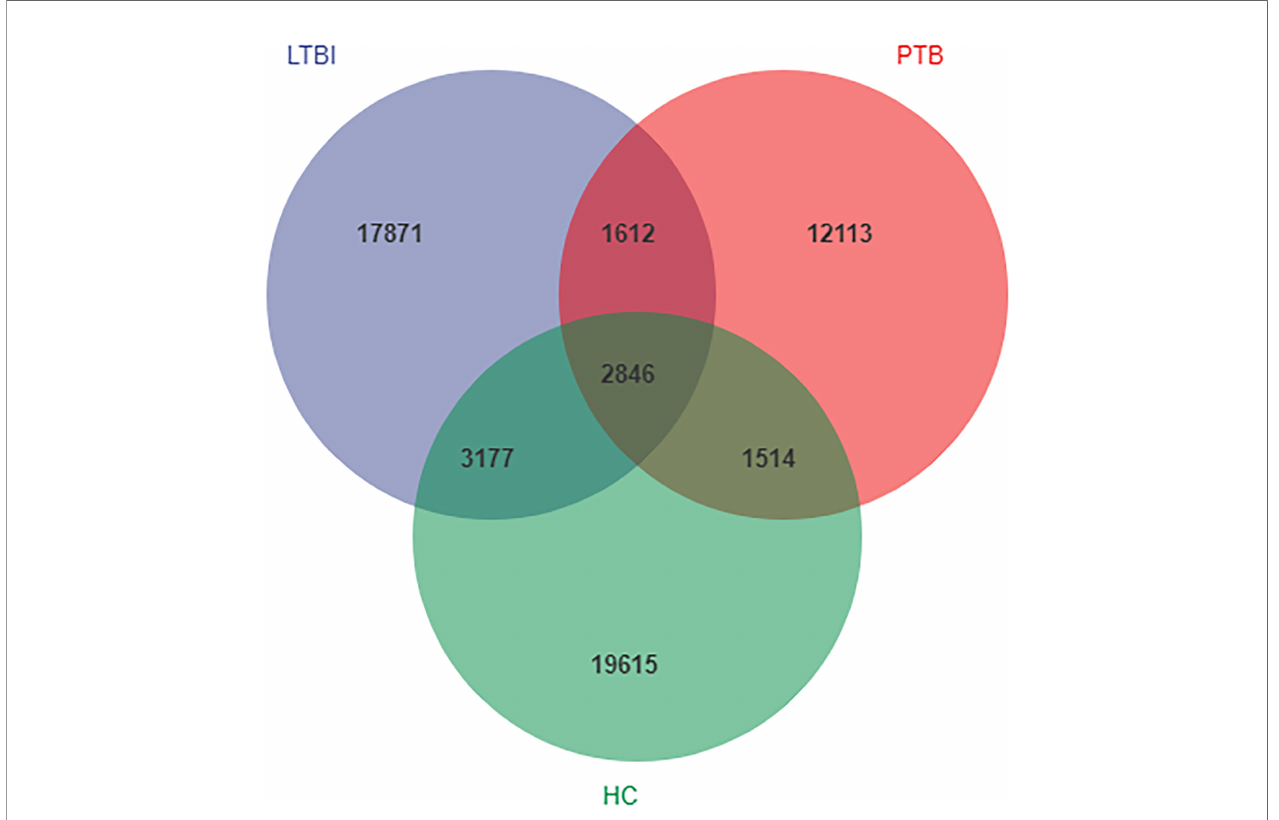
FIGURE 1 | Venn diagram showing the shared and unique amplicon sequence variants (ASVs) in the fl ora of the three